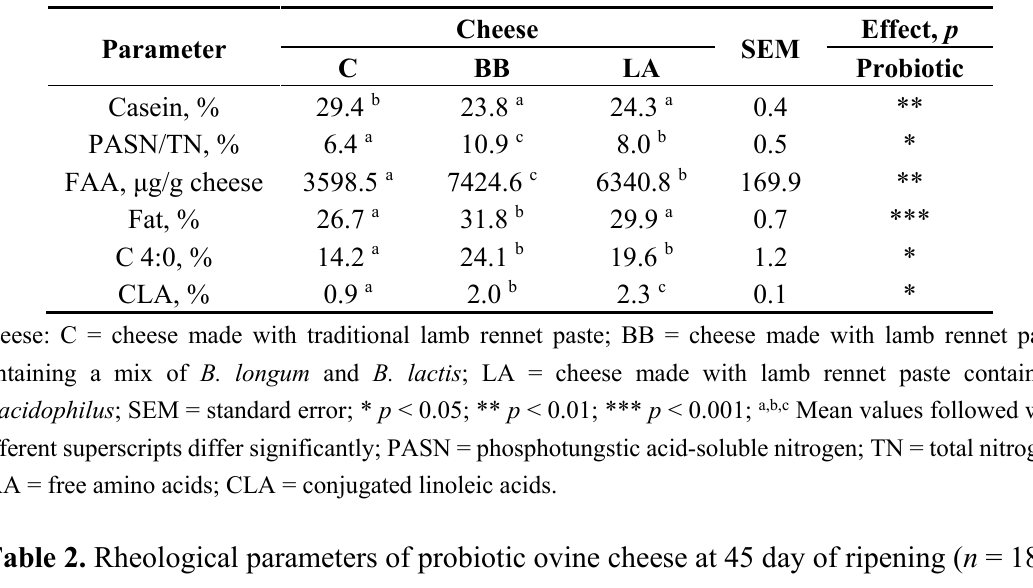
Table 2. Rheological parameters of probiotic ovine cheese at 45 day of ripening ( n = 18).